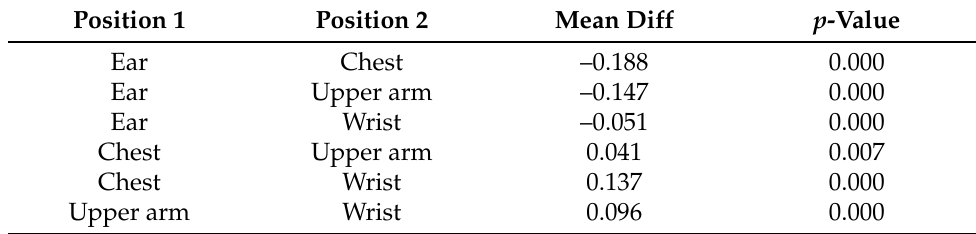
Table 7. p -values of accuracy between two